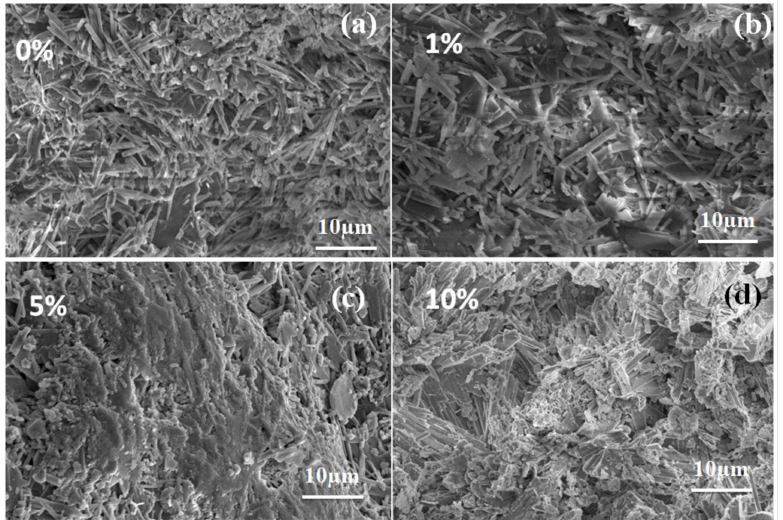
Figure 4. Typical SEM images of POP–BiF 3 (%) composites along with the concentration variation of